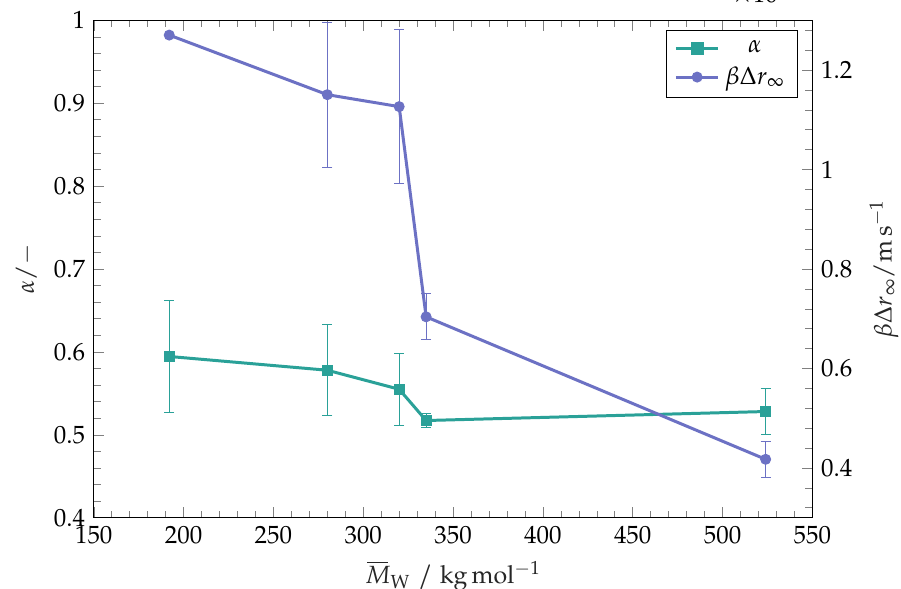
Figure 4. Wetting characteristics for initial and late stage wetting of toluene on polystyrene coatings with different molar masses. Initial wetting dynamics are characterised by α from Equation (3). Late stage dynamics are characterised by the first temporal derivation of Equation (1) at ∆ τ = 0, or the inaugural wetting speed of late stage wetting, respectively. The error bars represent the standard deviation of the mean values. The experimental point corresponding to β ∆ r ∞ for M W = 192kgmol − 1 contains no bars. This experiment has been performed only